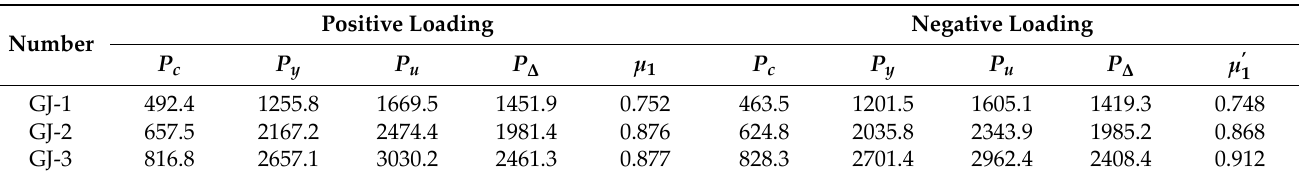
Table 1. Cracking load, yield load, peak load, failure load, and yield strength ratio of three compo‑ nents (unit: